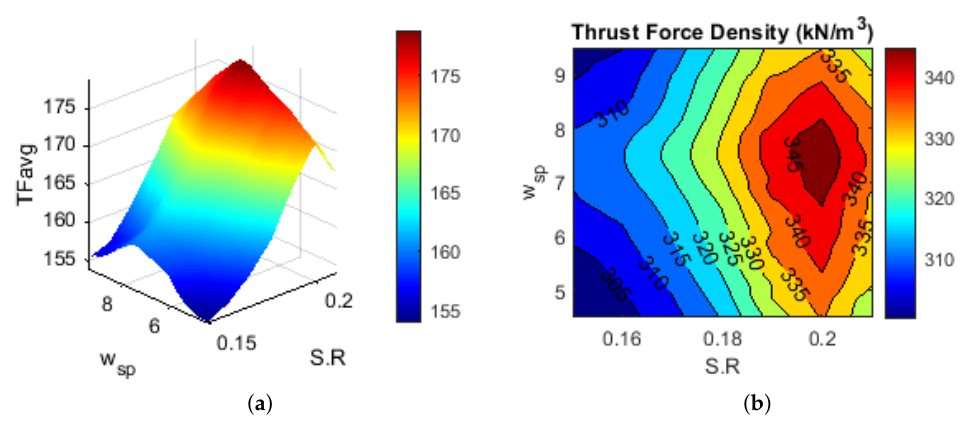
Figure 8. Influence of S.R and w sp on ( a ) TF avg ( b ) TFD .